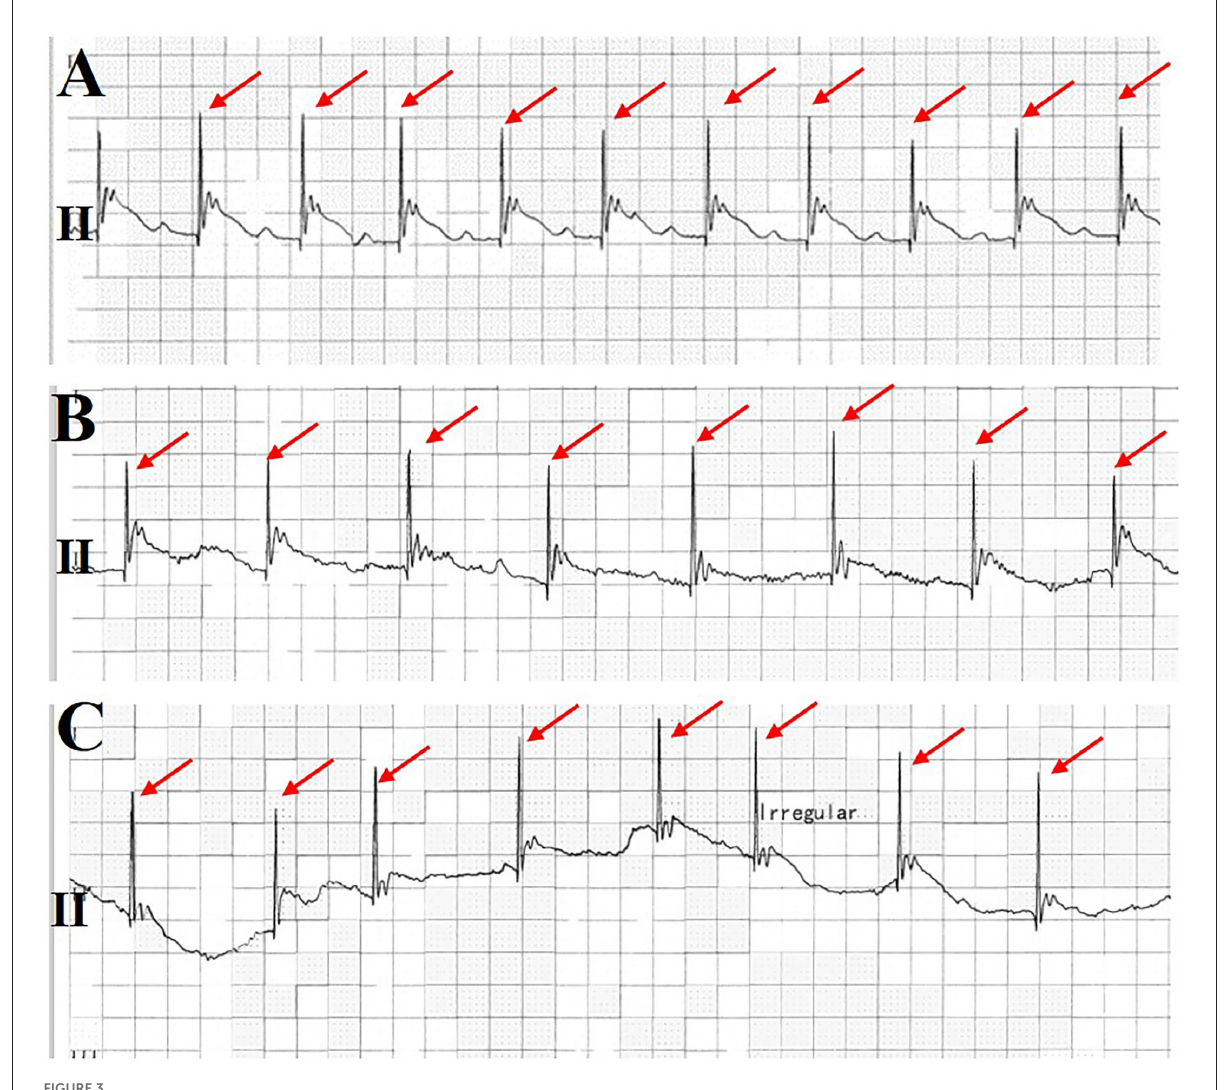
FIGURE3 Monitoring electrocardiogram (ECG) at lead II. It was found that the pacemaker gradually lost capture before the patient lost consciousness (A–C) . Ventricular pacing spikes are shown in a red